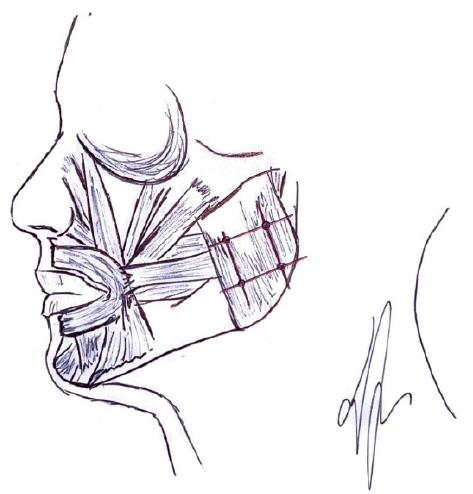
Figure 2. Injection site zone. A grid of 1-cm intervals is drawn on the area overlying the low and lateral side of the jaw and 2-cm from the zygomatic bone. Injections were performed on the crossed points. Four site injections per side were given.